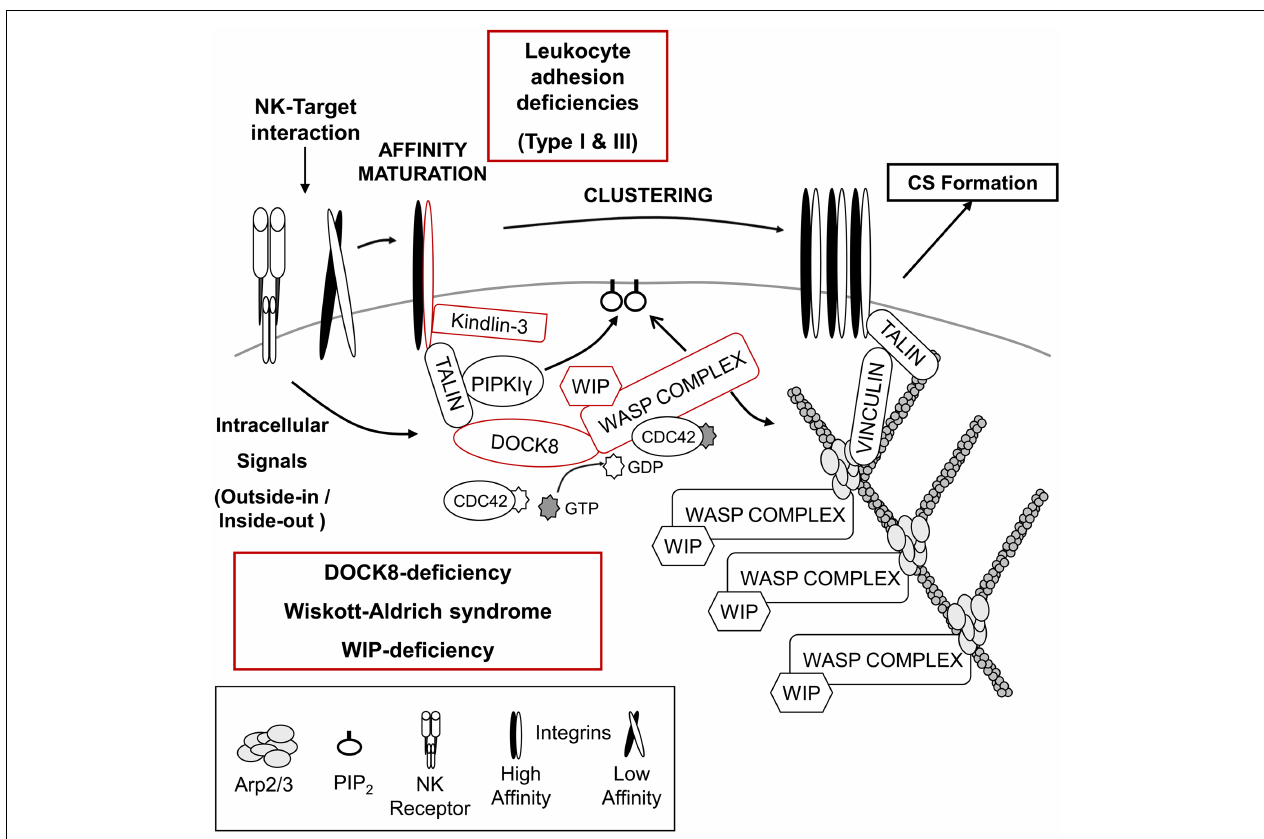
binding and/or defective NK cell activation.The DOCK8–WASP complex is also recruited to the NK-target interface, and a “DOCK8–CDC42– WASP” pathway is likely responsible for F-actin reorganization, which might facilitate integrin-mediated adhesion and provide the F-actin meshwork critical for organization of the CS. Absence of either DOCK8 orWASP results in primary immunodeficiency disorders and NK cells from these patients show impaired NK cytotoxic activity (see text for